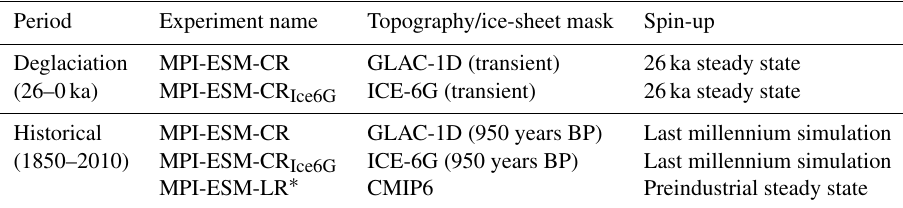
Table 2. Simulations performed, as described in Sect. 2.3. For the deglaciation experiments, the topography and ice sheets are taken from reconstructions and change throughout the simulation. For the historical and last millennium simulations, those fields remain constant through time.